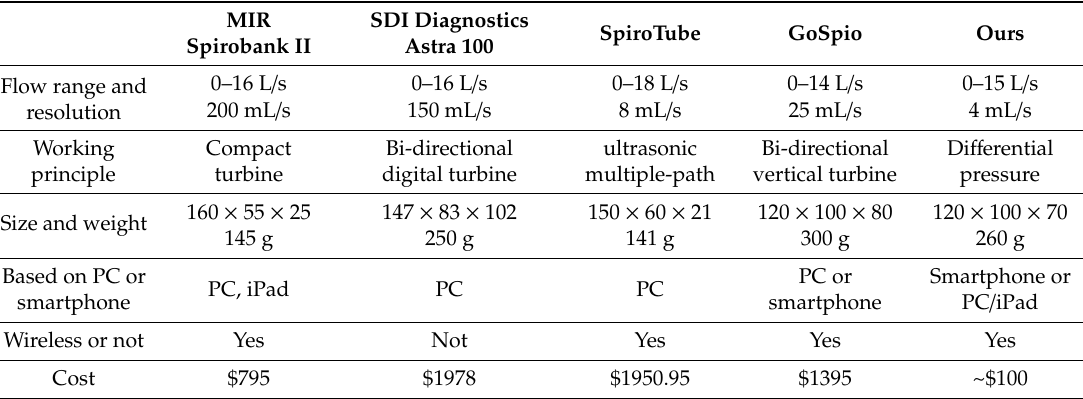
Table 3. Comparison of the developed spirometer with commercial